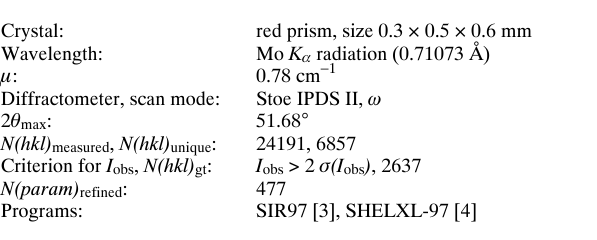
Table 1. D a t a collection a nd h a